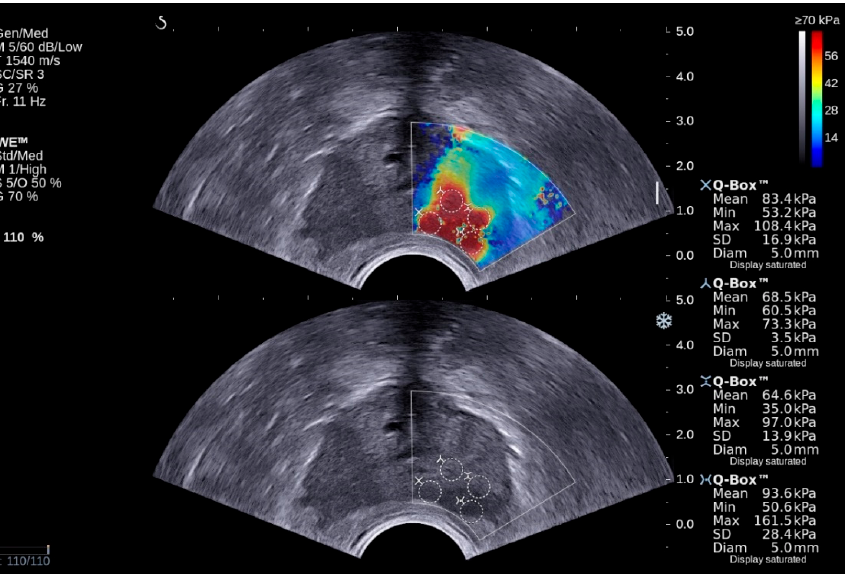
Figure 2. Concomitant transrectal visualization of the prostate bidimensional shear wave elas- tography (upper image) and grey-scale ultrasonography (lower image). Four regions of interest raise the suspicion of PCa (colored in red) at the level of the left prostatic lobe, and three of them were targeted during transrectal prostate biopsy. The pathology report has confirmed the PCa le- sions in all three biopsy cores.